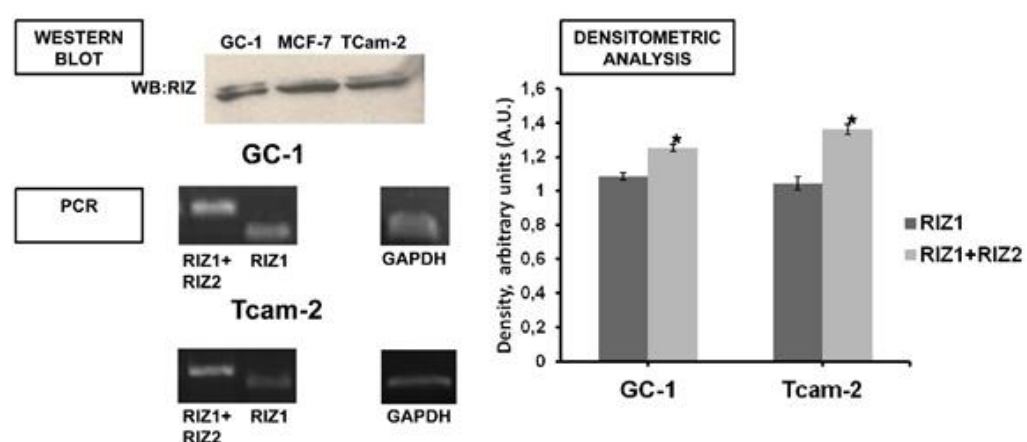
Figure A1. RIZ expression in GC-1 and TCam-2 cell lines. Western blot analyses of total protein cell extracts from GC-1 and TCam-2 cell lines with RIZ1 antibody. MCF-7 cell extract was used as a control. Electrophoresis analysis of amplicons obtained by RT-PCR of cDNA from GC-1 and TCam-2 cells in basal condition (6% FBS DMEM for GC-1 cells and 10% FCS RPMI 1640 for TCam-2 cells). Densitometric analysis of the gels derived from three independent experiments, normalized for GAPDH